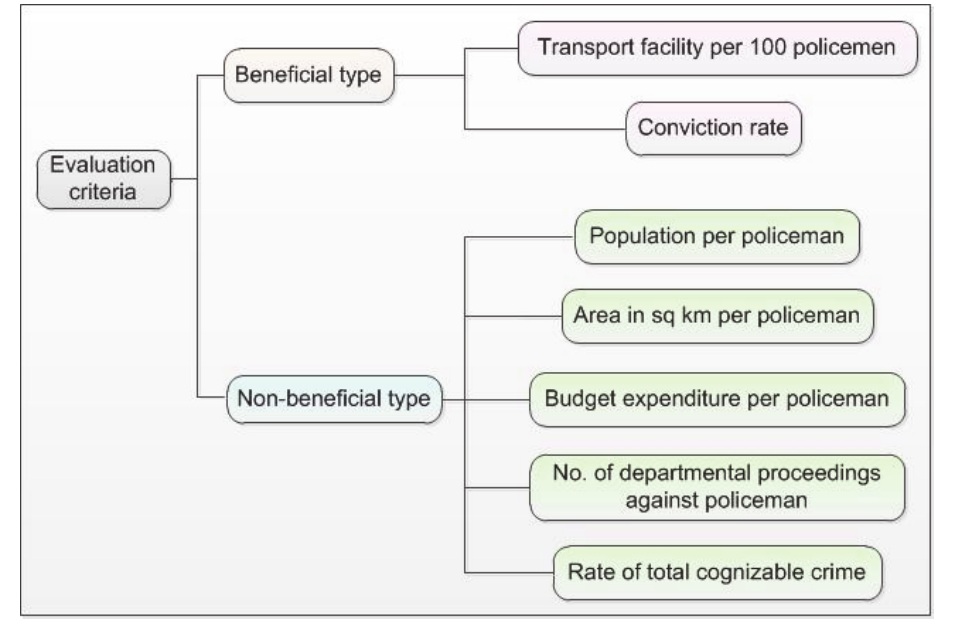
Fig. 1. Classification of criteria for police performance appraisal Seven considered criteria and their weights Sl.